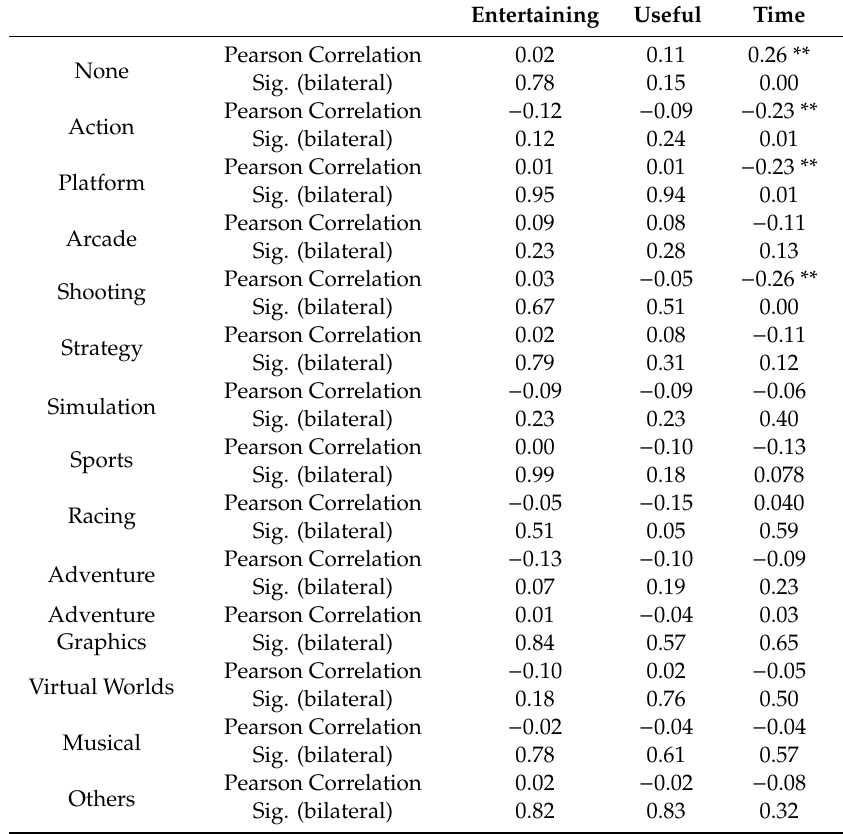
Table 6. Correlations between types of games, number of hours spent playing and Stigma Stop ratings for usefulness and